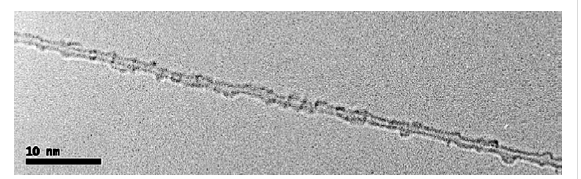
Figure 11: TEM image of a SWNT; the uneven surface shows the attachment of functionalized groups. Reproduced with permission from [36], copyright 2009